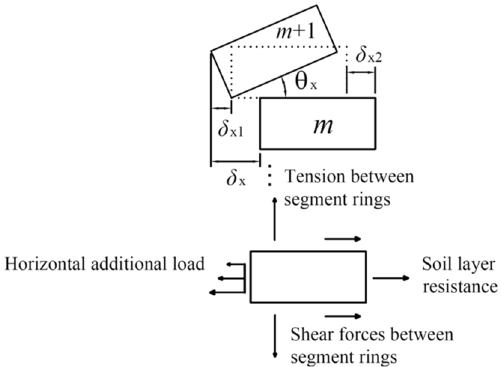
Figure 10. Calculation model for collaborative deformation of rotation and dislocation between shield tunnel segment rings 15